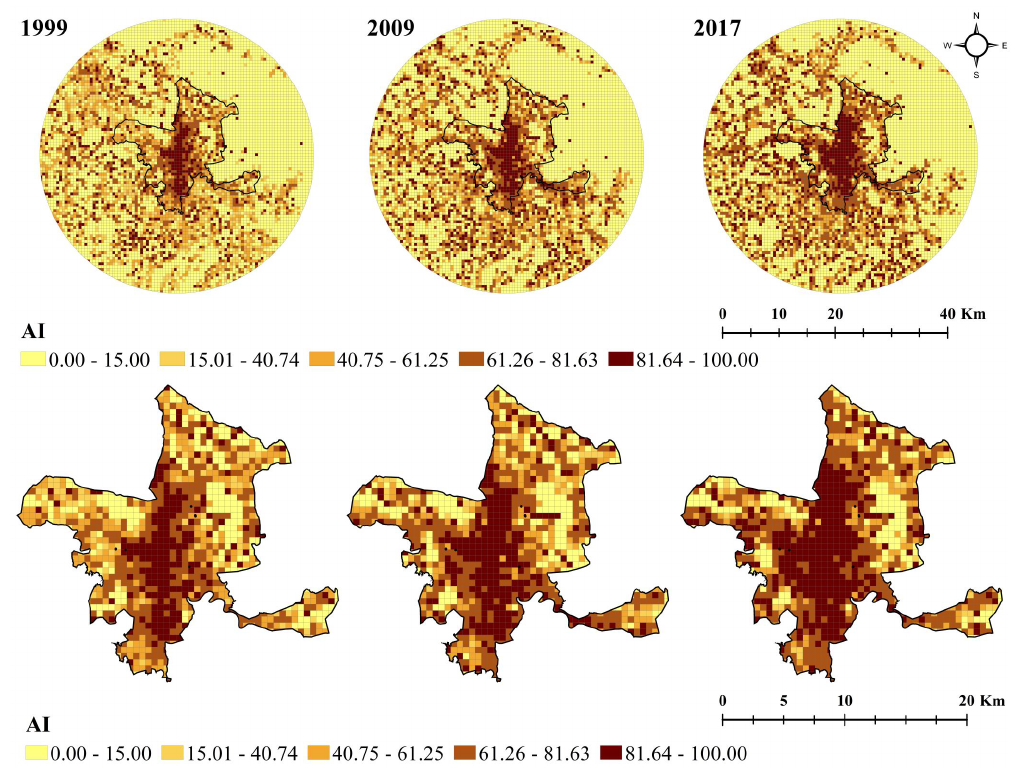
Figure 12. Aggregation Index (AI) change at 500 m cell size with enlarged view of CA, year 1999, 2009 and 2017 in the study